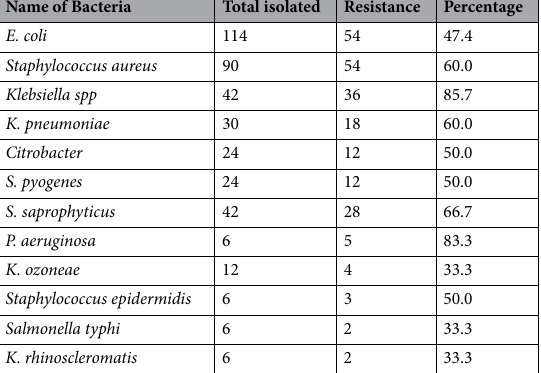
Table 3. Overall bacterial resistance to ceftriaxone at GAMBY Teaching General Hospital.